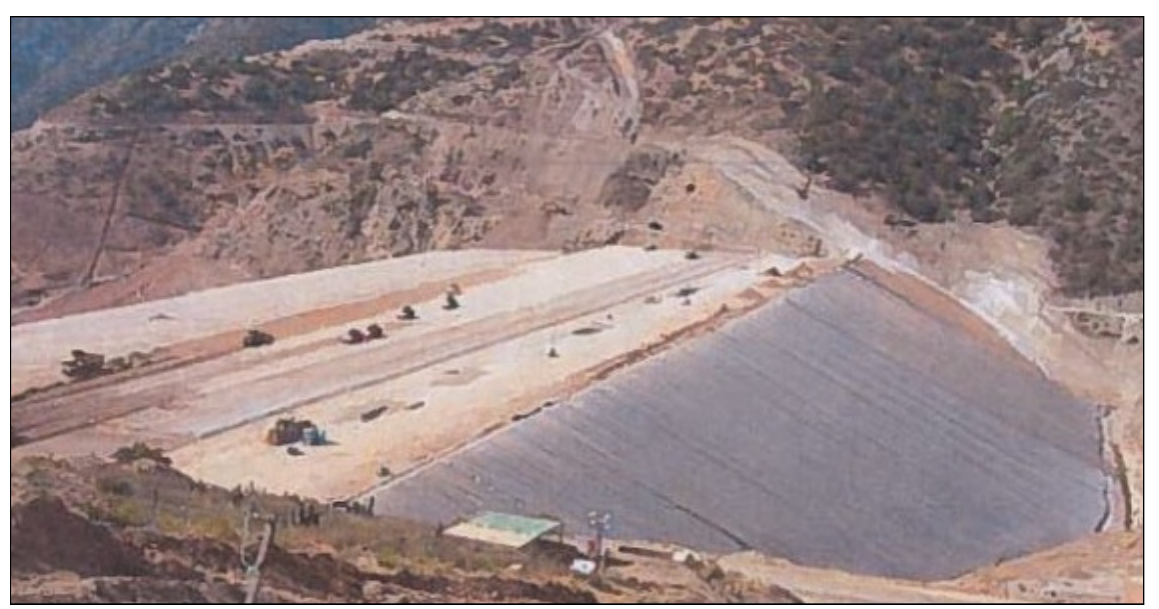
Figure 16. Starter dam upstream face geotextile–geomembrane liner installation first stage finished—TSF Starter Dam, Chile [42,43].